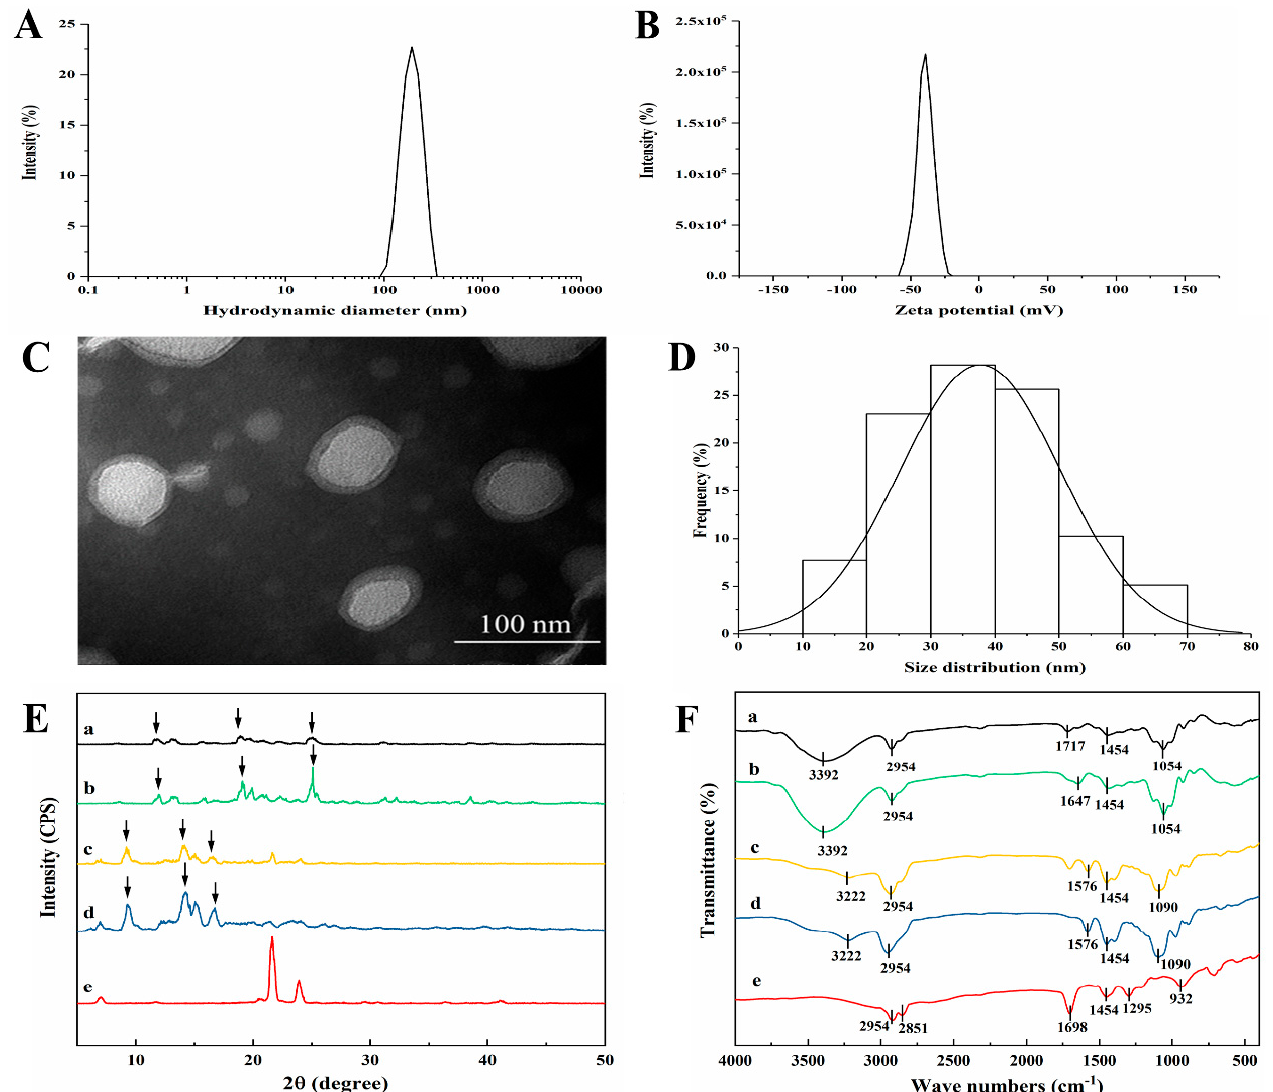
Figure 3. Characterization of the optimized MAD–NLCs. ( A ) Hydrodynamic diameter (HD) and ( B ) zeta potential (ZP) of the MAD–NLCs were determined by DLS. ( C ) The morphology of the MAD–NLCs was observed by TEM, and ( D ) the size distribution was obtained via analysis of the particles from several TEM images. ( E ) XRD patterns and ( F ) FTIR spectra for (a) MAD–NLCs, (b) blank NLCs, (c) the physical mixture, (d) MAD, and (e) SA were shown.